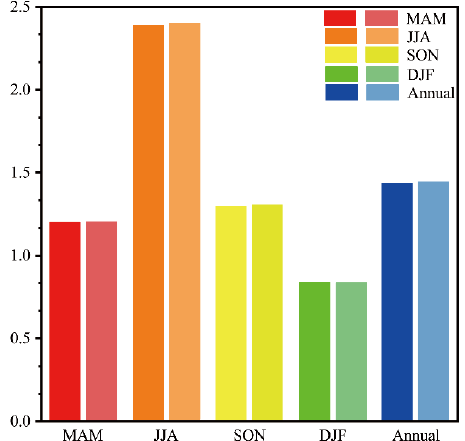
Figure 10. Seasonal and annual average sulfate aerosol concentrations ( µ g kg − 1 ) over eastern China (24–43° N, 101–126° E) during the daytime ( left ) and nighttime ( right ) in 2010.